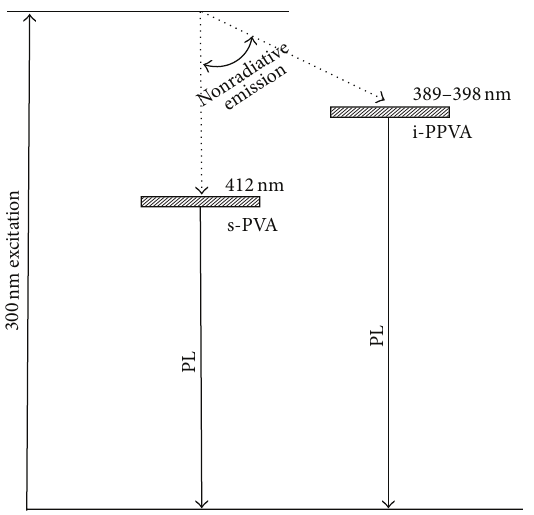
Figure 8: Energy level diagram which shows PL emissions and nonradiative processes occurring simultaneously in s-PVA and i- PPVA polymer molecules at a resonance excitation of 300 nm.